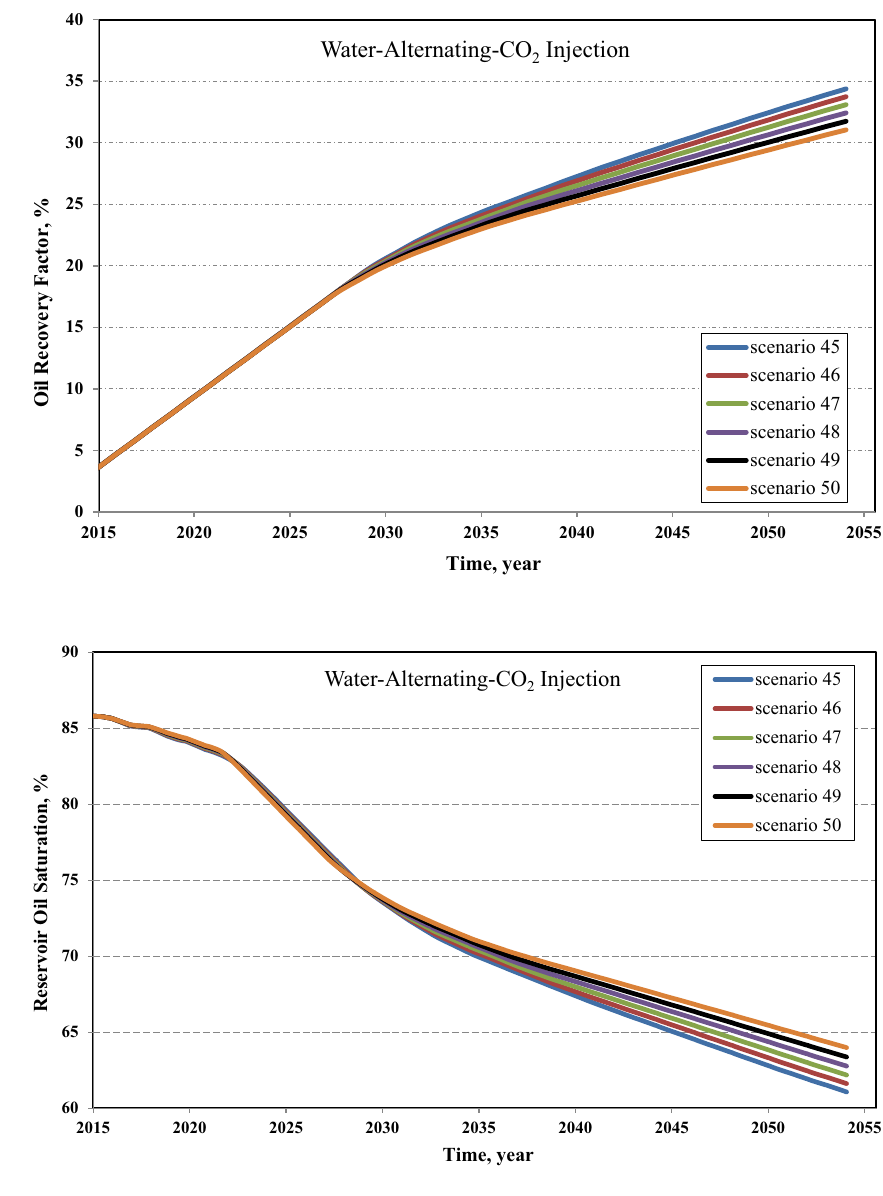
Fig. 17 Oil recovery factor for water-alternating-CO 2 injection into different reservoir layers